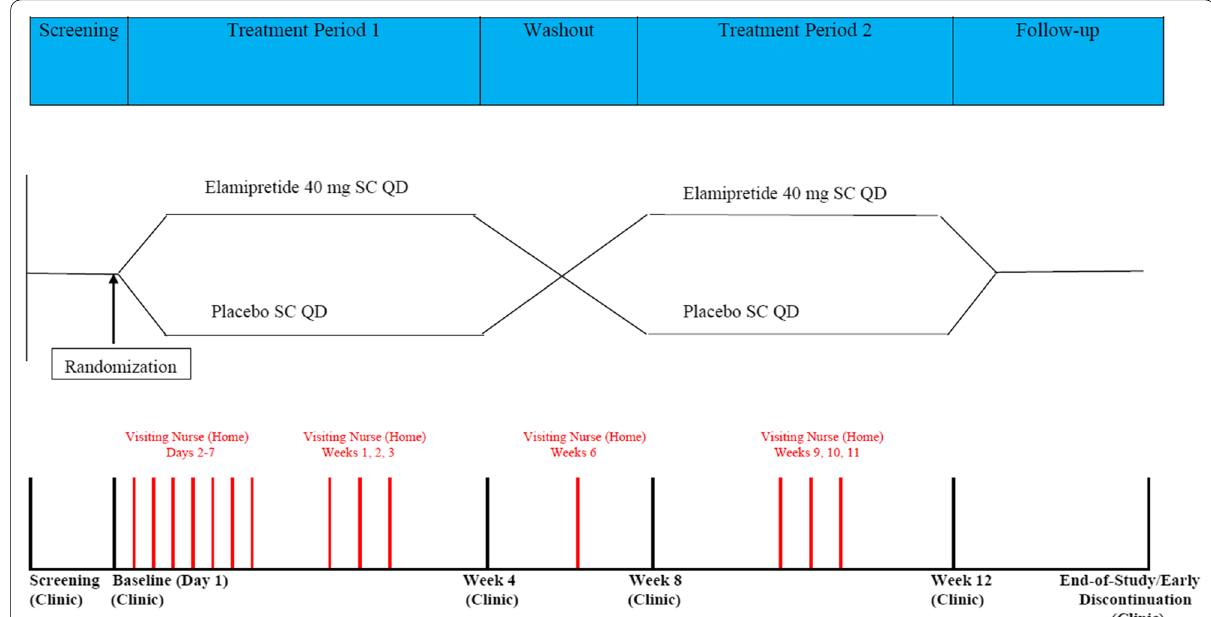
Fig. 1 Study schematic. Note: The Primary Mitochondrial Myopathy Symptom Assessment (PMMSA) was administered daily starting at the screening visit. All reference measures (Quality of Life in Neurological Disorders [Neuro-QoL] Fatigue item bank, Physician Global Assessment [PhGA], Patient Global Assessment [PGA], six-minute walk test [6MWT], Triple Timed Up and Go [3TUG] Test, Scale for the Assessment and Rating of Ataxia [SARA]), except for the “most bothersome” item, were administered during each of the study center (“Clinic”) visits. The Neuro-QoL